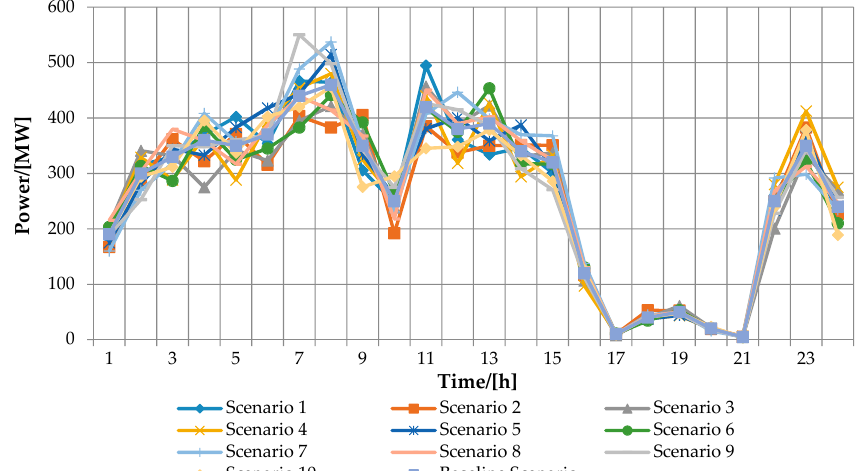
Appl. Sci. 2017, 7, 1154